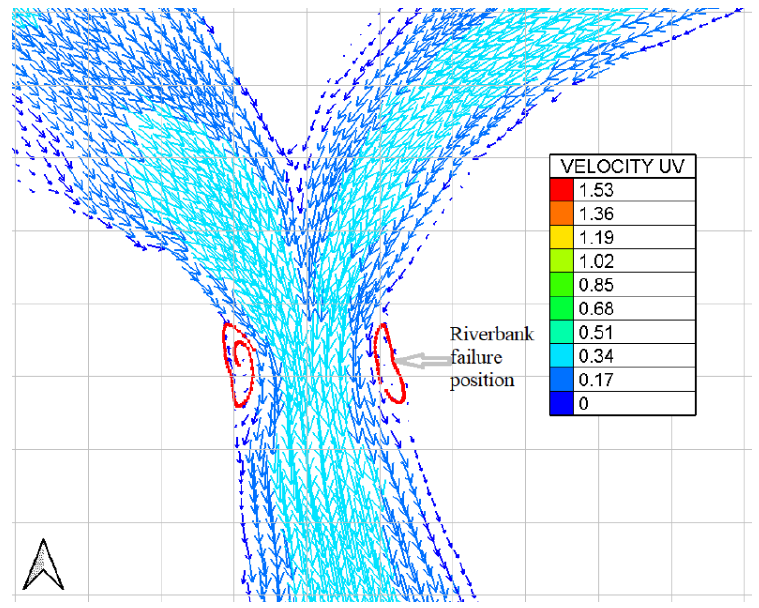
Figure 6. Average flow velocity (VELOCITY UV) in the dry season in 2017 (m/s).